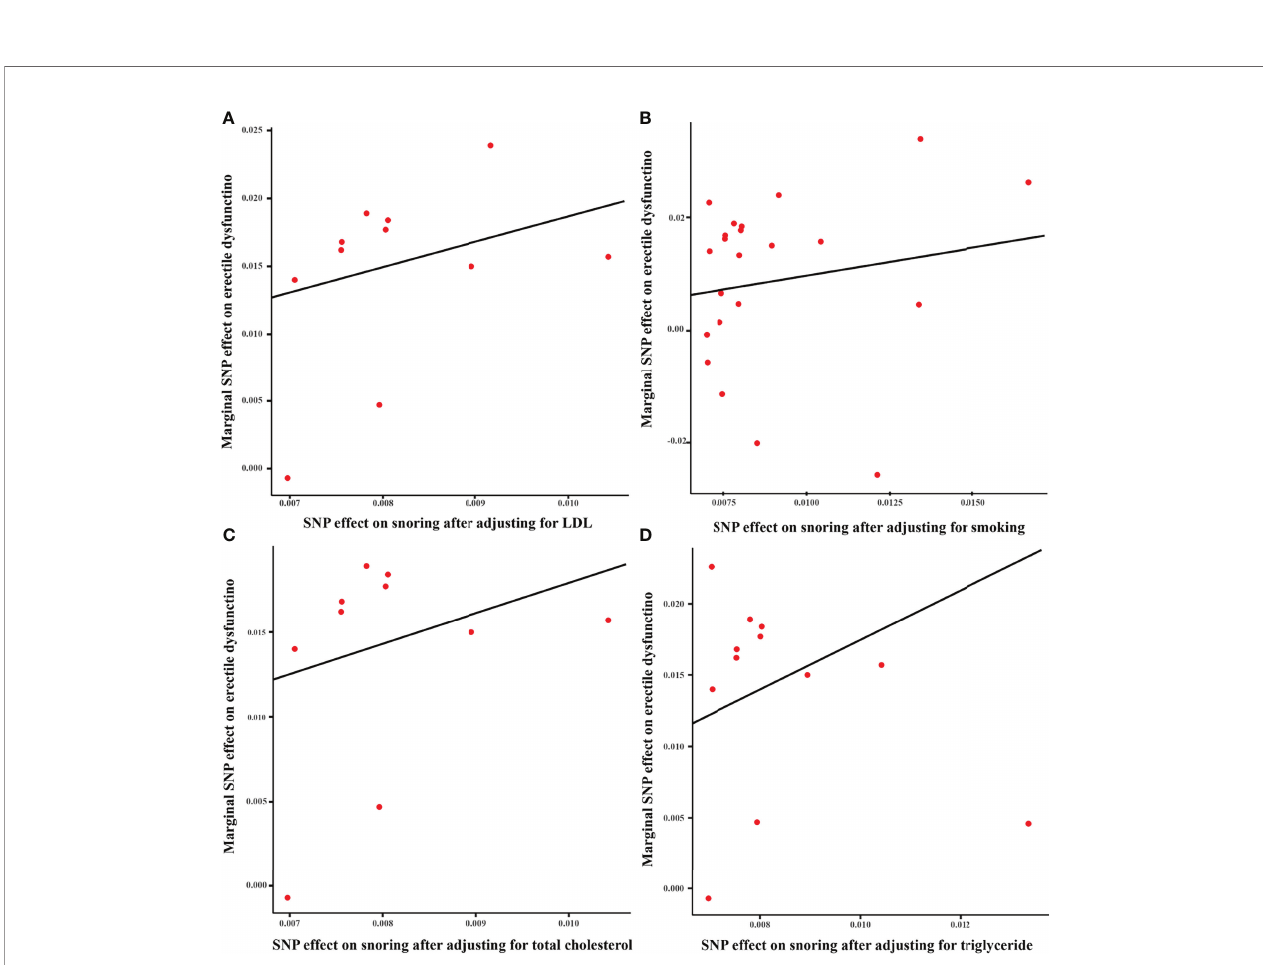
FIGURE 4 | Scatter plot of the effect size of each SNP on snoring and ED in MVMR. (A) Scatter plot adjusting for LDL; (B) Scatter plot adjusting for smoking; (C) Scatter plot adjusting for total cholesterol; (D) Scatter plot adjusting for triglyceride. SNP, single nucleotide polymorphism; LDL, low-density lipoprotein; ED, erectile dysfunction; MVMR, multivariable mendelian randomization.